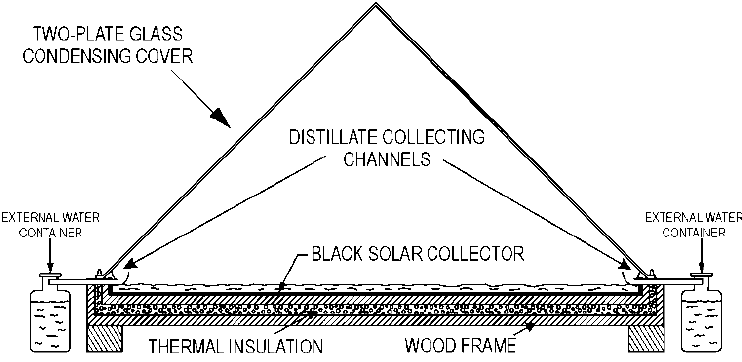
Figure 6. Sketch of a single ‐ effect double ‐ slope condenser solar still.